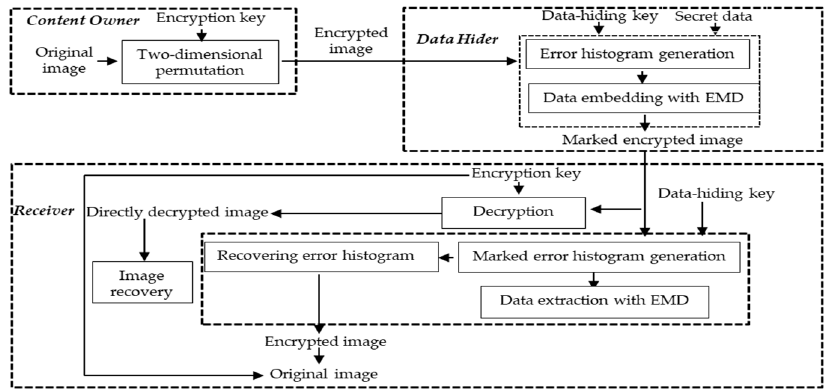
Figure 1. Block diagram of the proposed method.